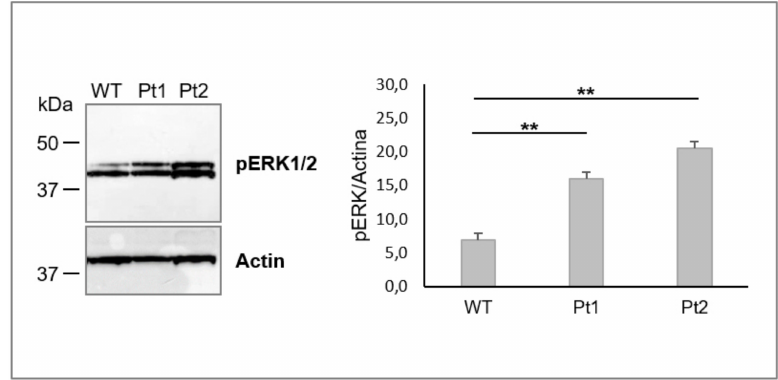
Figure 6. Analysis of phospho-extracellular-signal-regulated kinase 1 / 2 (pERK1 / 2) expression in U251 astrocytoma cells overexpressing MLC1 WT or carrying Pt1 and Pt2 pathological mutations. ( A ) WB analysis performed on 40 µ g of protein cytoplasmic extract shows a significative inhibition of pERK1 / 2 in MLC1 WT cells when compared to the mutant Pt1 and Pt2 cells. Actin is used as a loading control. Molecular weight markers are indicated on the left (kDa). One representative experiment out of three performed is shown. ( B ) Densitometric analysis of pERK1 / 2 protein bands normalized with the amount of actin in the same samples is evaluated for each cell fraction. The bar graphs represent means ± SEM of three independent experiments. Statistical di ff erence was calculated using the Kruskal-Wallis test (** p <